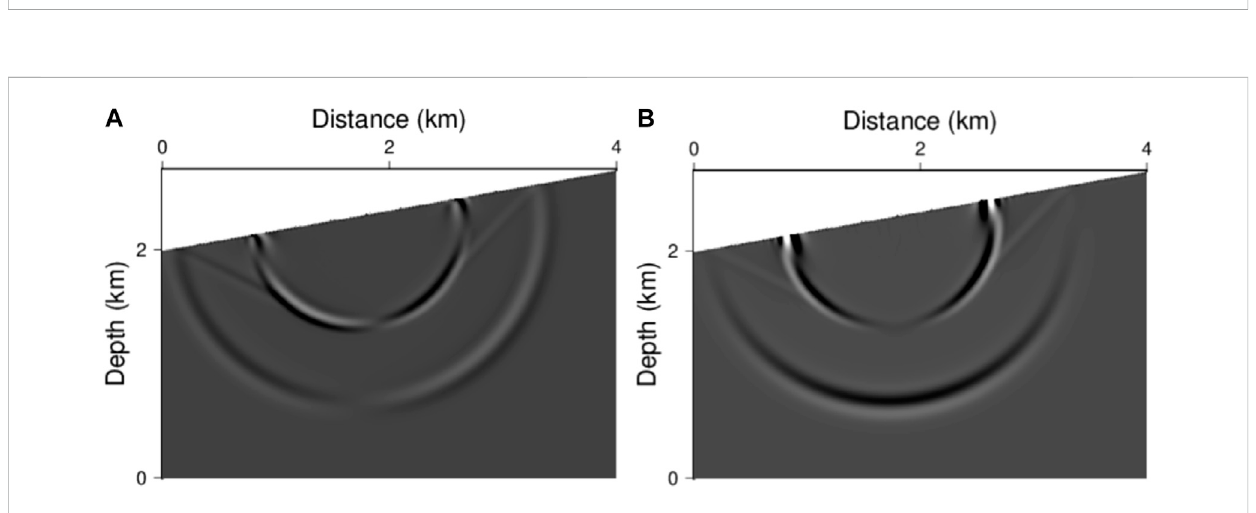
FIGURE 8 Snapshots of the elastic wave fi elds at t = 0.6 s (A) u 1 and (B) u 2 .